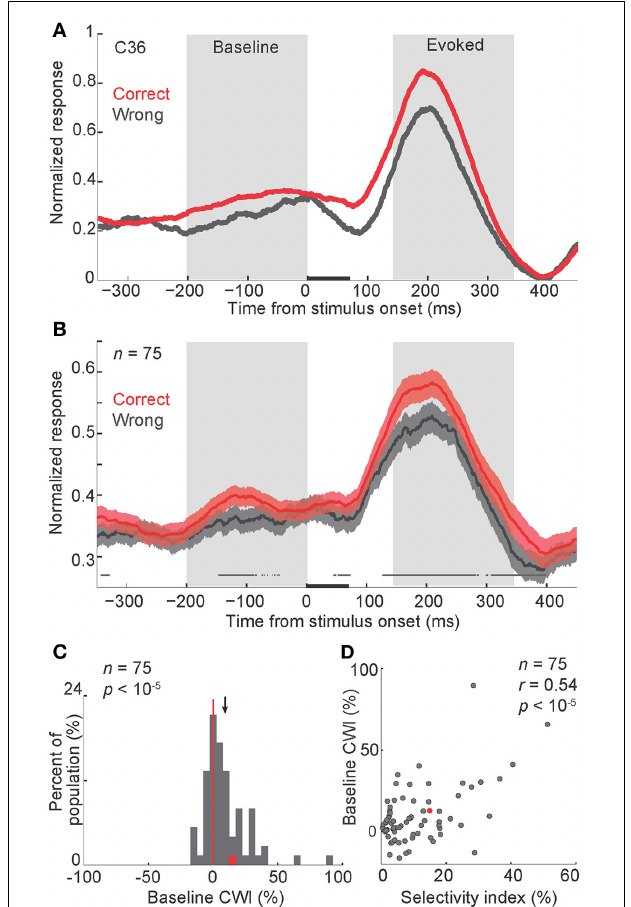
FIGURE 2 | Modulation of baseline activity in correct vs. wrong trials. (A,B) Normalized firing rate in correct and wrong trials, in a representative body neuron (C36, selectivity index = 0.15) (A) , and across all neurons (B) . In each neuron and each signal level, the peak response was measured separately in correct and wrong trials. The larger peak was selected to normalize both correct and wrong trials. Finally the normalized firing rates were averaged across noise levels. The gray boxes represent periods of baseline and evoked activity used for the further analysis. In (B) shaded areas represent s.e.m. of correct and wrong responses across the population. The line above the X-axis represents the significant difference between correct and wrong responses, obtained by paired t -test in 50-ms sliding windows with 1-ms steps, plotted at the middle of each bin ( t -test, alpha = 0 . 05). Stimuli were presented for 70ms, represented by a black bar on the X-axis. P -values represent the t -test results for comparing the firing rates between correct and wrong trials during baseline or evoked windows. “n” here and in all other figures represents the number of body neurons included in the analysis. (C) Histogram of the CWI (correct/wrong index) in the baseline period. The red data-point corresponds to the representative neuron shown in panel a (C36). The red vertical line shows the line of no difference (zero). The arrow represents the mean of the distribution. (D) The relationship of baseline CWI with the selectivity index. Each data-point corresponds to one neuron. Conventions as described in (C)